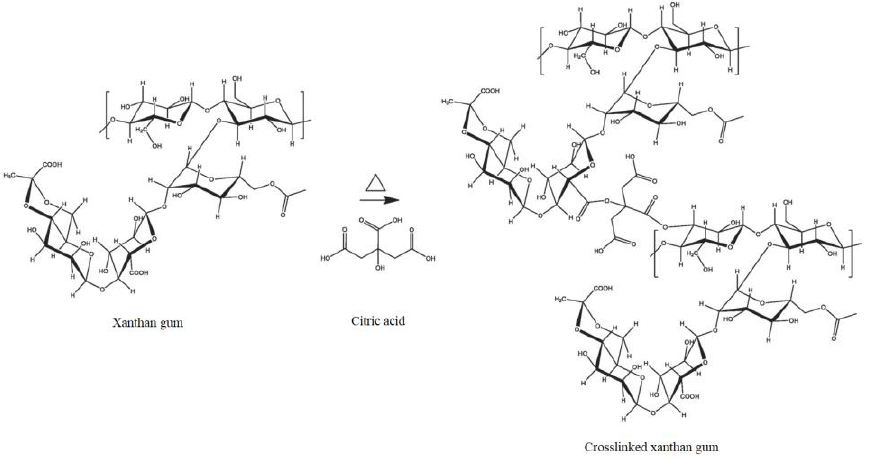
Figure 14. Reaction scheme of the xanthan gum with citric acid (reprinted with permission from [67]). Table 2. List of the prepared hydrogel composites, used as SCs.